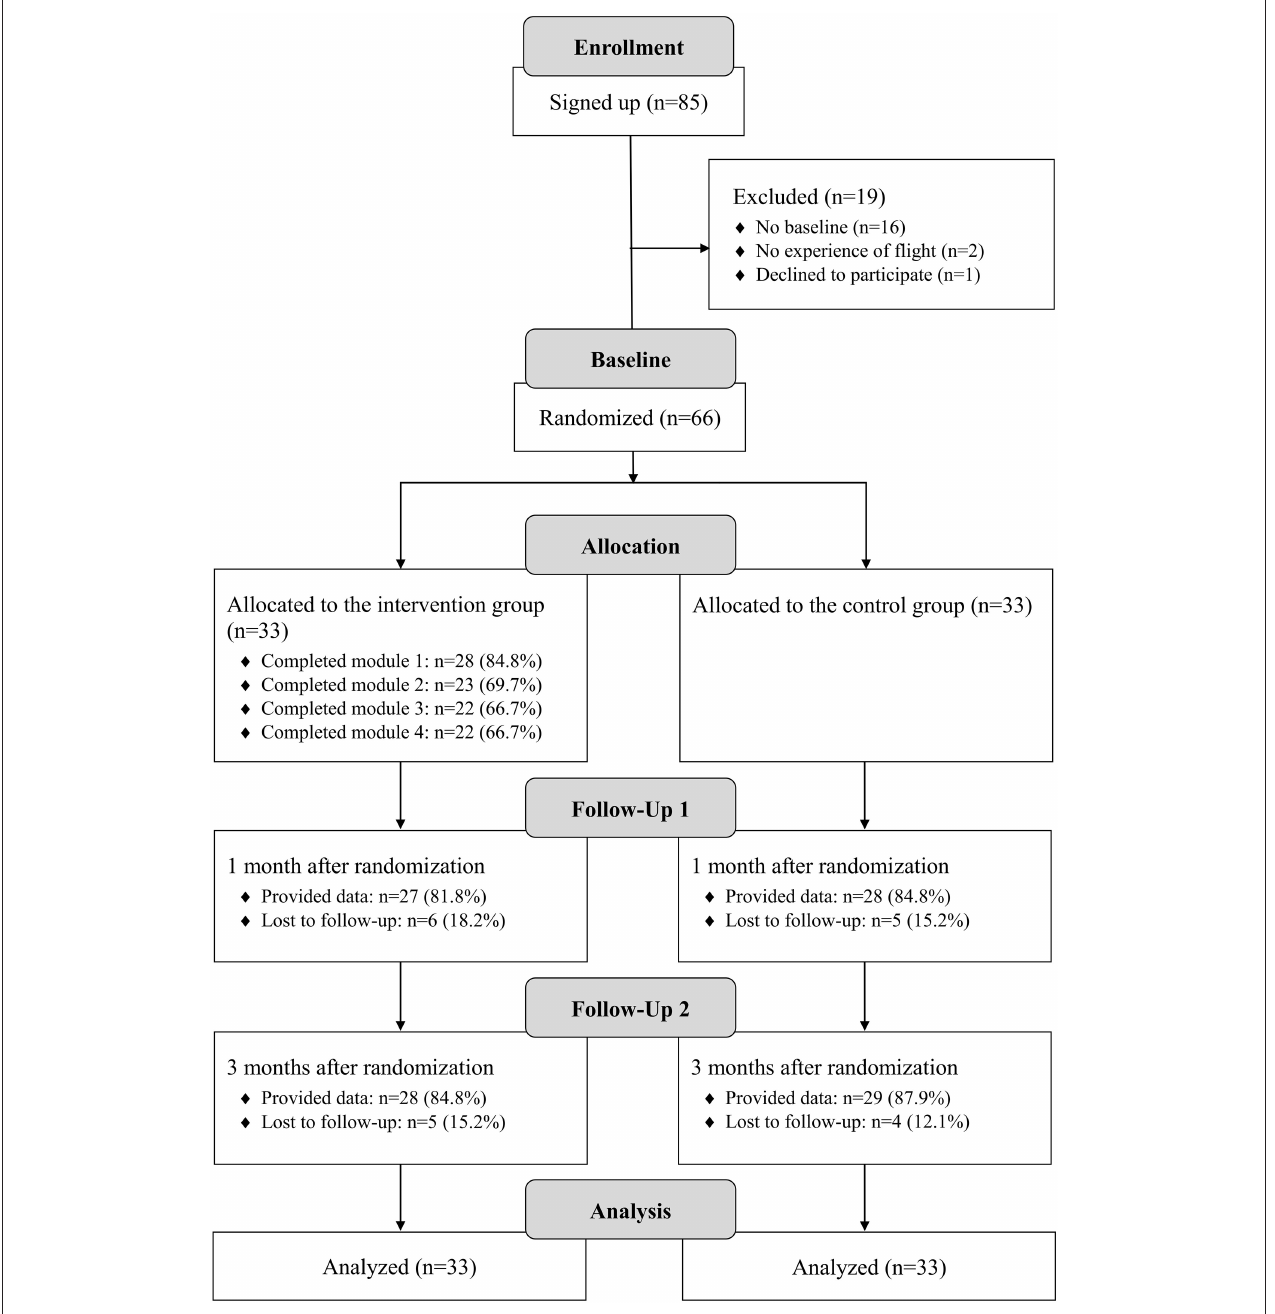
FIGURE 1 | Study flow